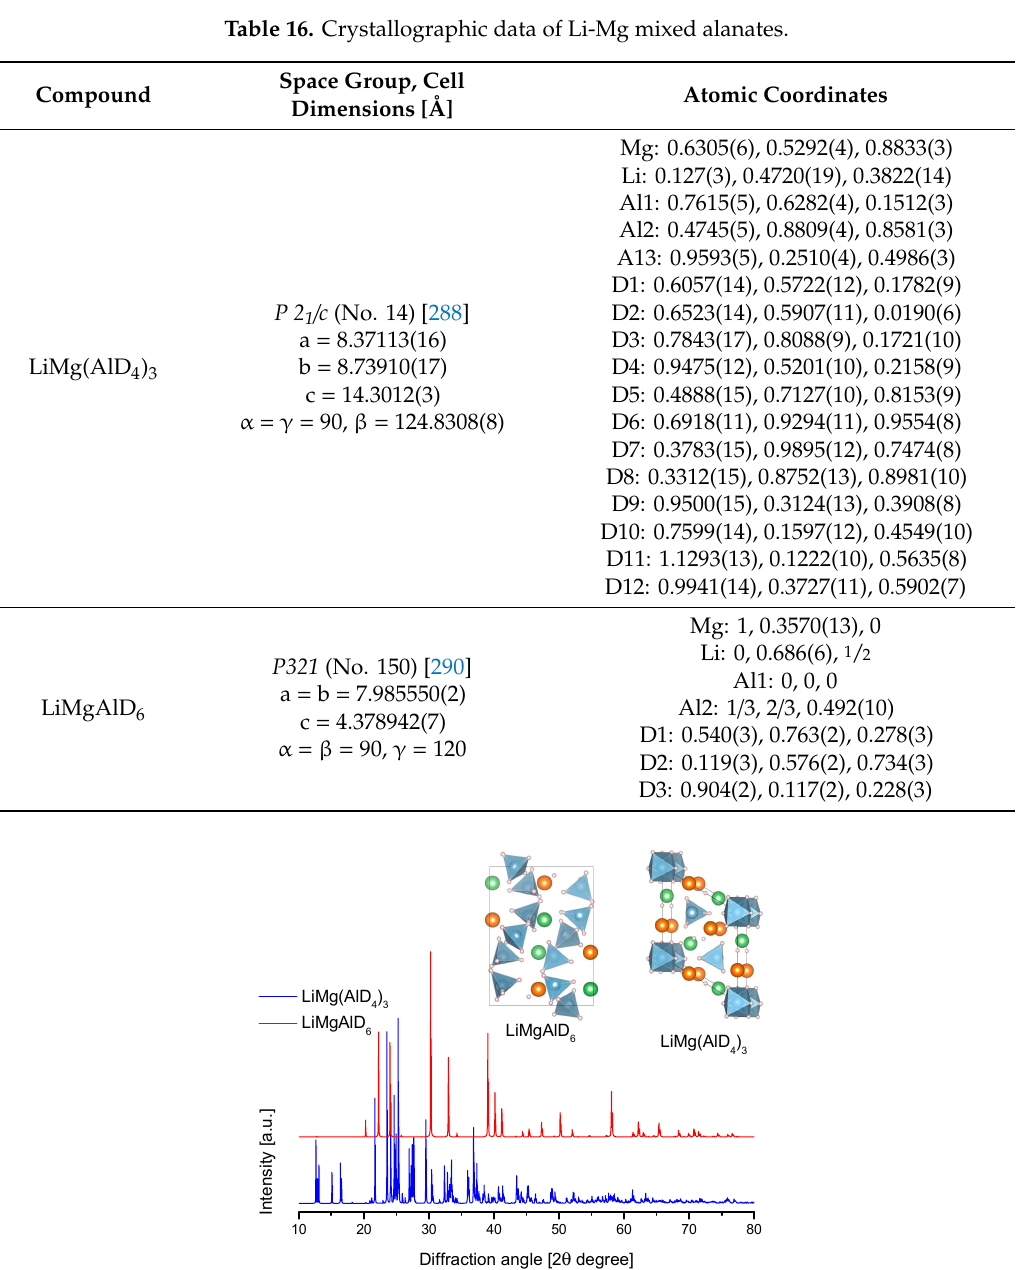
Figure 24. Crystal structure of Li-Mg alanates and its calculated diffraction patterns ( λ = Cu k α 1 )